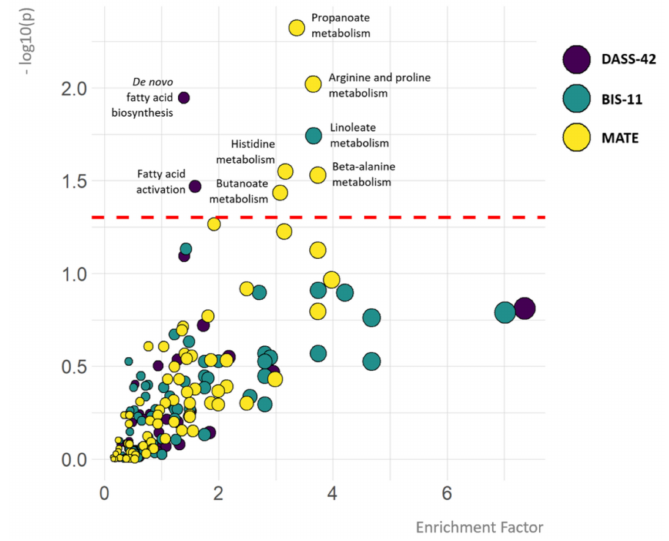
Figure 1. Metabolic pathways associated with depression, anxiety and stress, impulsivity and substance use. The colour of the circles represents the psychiatric outcome (DASS-42, BIS-11 or MATE-Q scores). The y -axis depicts the significance of the association between pathways and DASS-42, BIS-11 or MATE-Q scores. Cut-off p = 0.05 equals − log10( p -value) = 1.3. The x -axis and size of the circles depict the enrichment factor, which refers to the ratio between the number of significant pathway hits and the expected number of compound hits within the pathway (no cut-off value). Only the names of metabolic pathways significantly associated with psychiatric outcome measures are